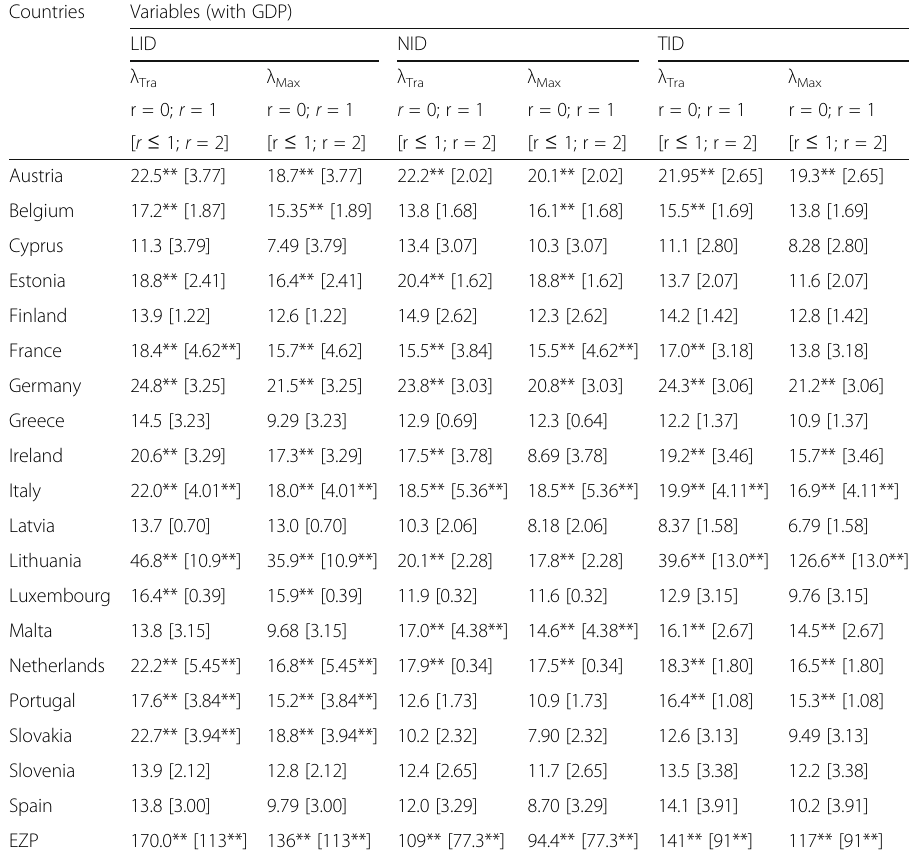
Table 3 Results of Cointegration